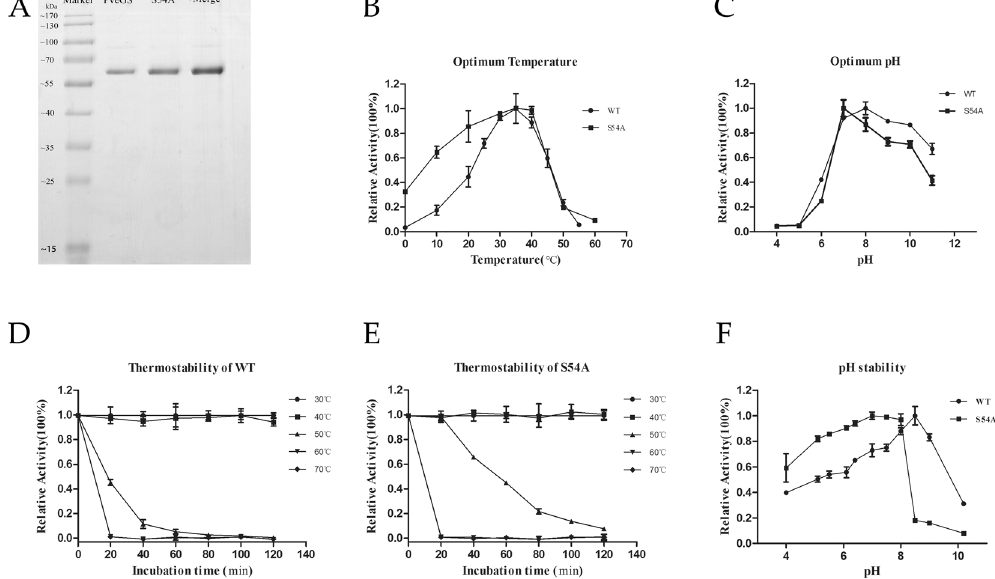
Figure 1. Expression and enzymatic analysis of Pve GS and S54A. ( A ) SDS-PAGE analysis of the purified glutamine synthetase produced in E . coli BL21. Marker lists the standard molecular weight and the lane of the wild Pve GS, mutant S54A and merged protein. ( B ) The optimum temperature of the wild type and S54A. The activity was determined at a gradient temperature ranging from 0 to 60 °C and activity at 35 °C was defined as 100%; ( C ) The optimum pH of the WT and S54A. The activity assay was carried out at 35 °C for 30 min and the specific activity under the optimum pH was defined as 100%. ( D ) and ( E ) Thermostability of WT and S54A was measured under different temperatures for 2 h, and samples were taken every 20 min for 2 h. The specific activity without incubation was defined as 100%. ( F ) pH stability of WT and S54A. The residual activity was measured at 35 °C for 30 min and the highest activity was defined as